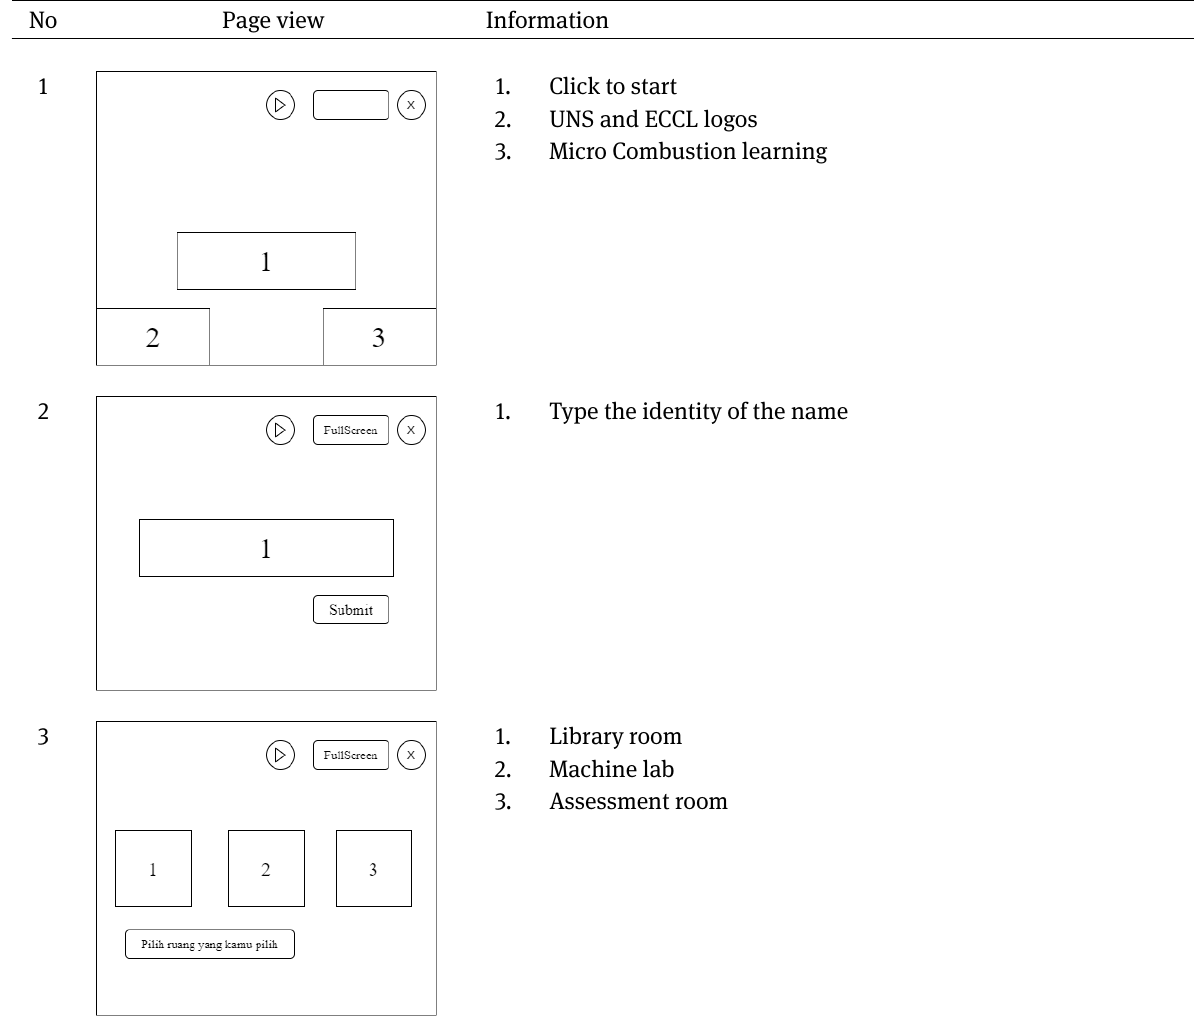
Table 2: Storyboard of a virtual laboratory for micropower generation learning No Page